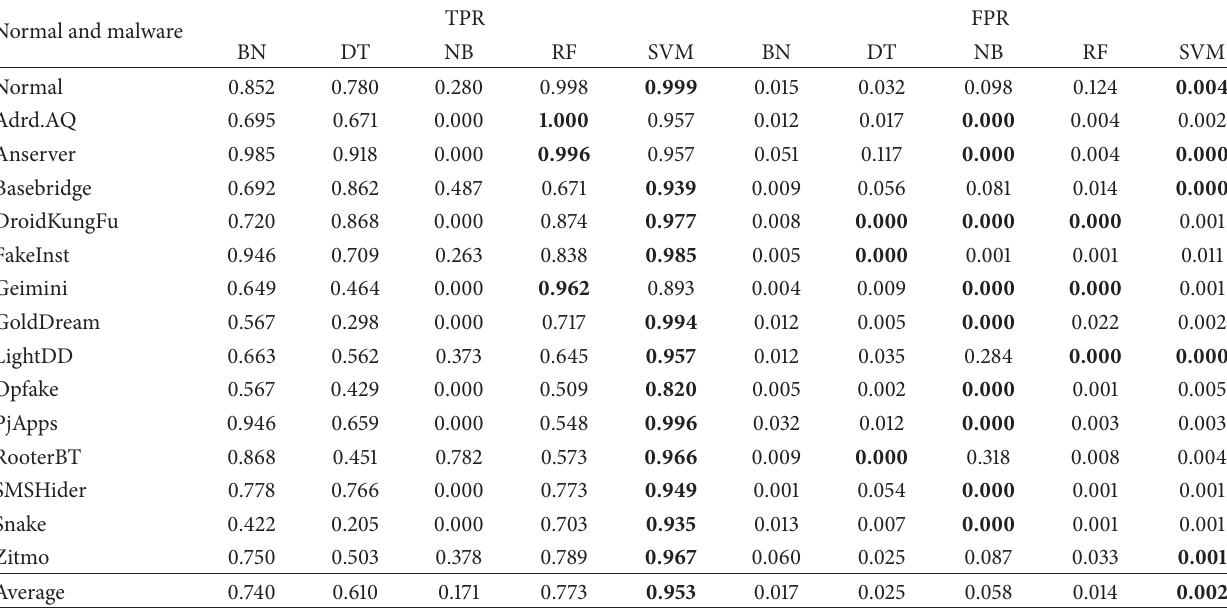
Table 5: Detailed performance indicators of machine learning classifiers (TPR/FPR).